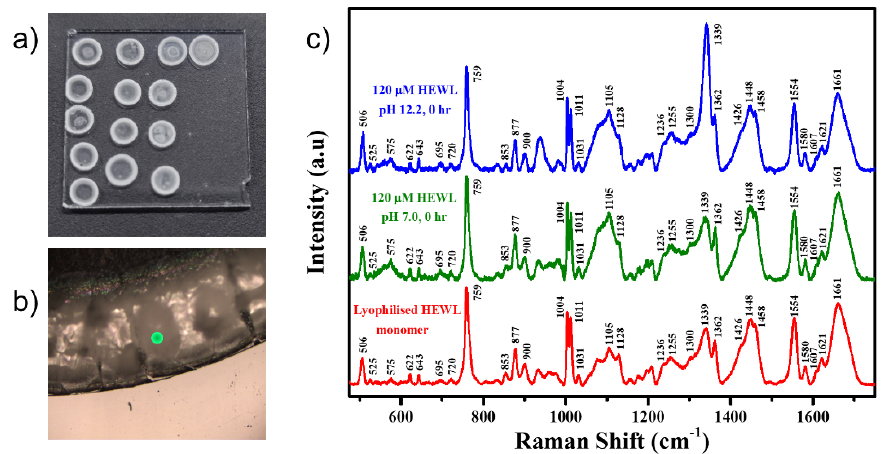
Figure 1. ( a ) Optical image of the rings formed when the HEWL sample was drop-casted onto a hydrophobic glass substrate and dried in a desiccator; ( b ) 10× magnified image of the outer ring of the drop, the site from where the Raman spectrum was collected; ( c ) Raman spectra collected from the lyophilized HEWL monomer (red), rings of the 120 μ M HEWL in pH 7.0 (green), and pH 12.2 (blue) at 0 h of the experiment.